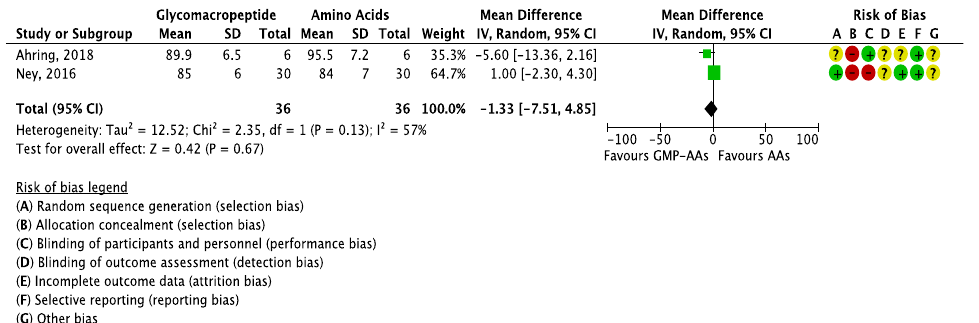
Figure 6. Forest plot of studies with data on the effect of glycomacropeptide interventions on blood urea nitrogen. The analysis included data from two studies with a total of 72 participants.AAs: synthetic protein derived from L-amino acids; CI: confidence interval; df: degrees of freedom; GMP-AAs: glycomacropeptide supplemented with amino acids; IV: intravitreal; SD: standard deviation.